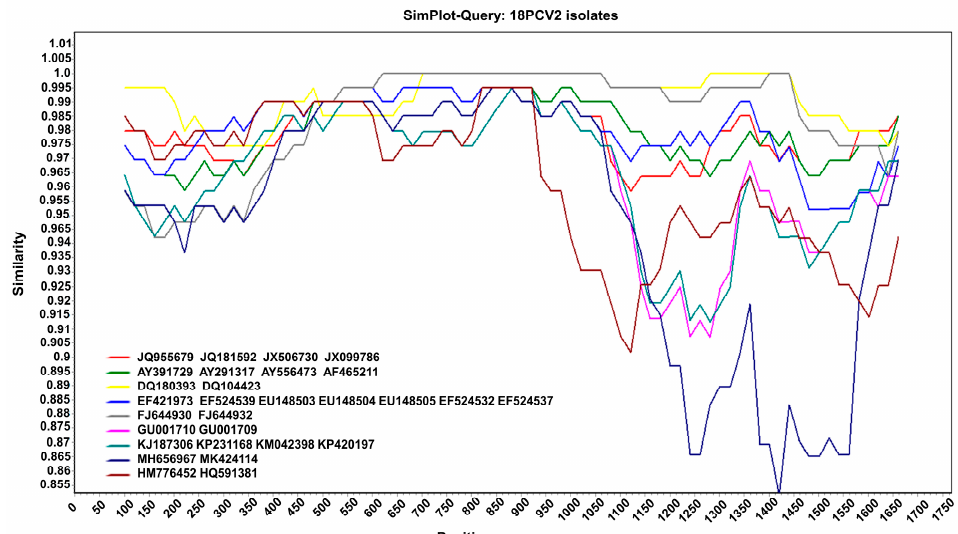
Figure 3. Recombination analysis. Nucleotide sequence similarity was assessed using SimPlot v.3.5.1. Sequence similarity between the 18 PCV2 isolates and 29 reference sequences.